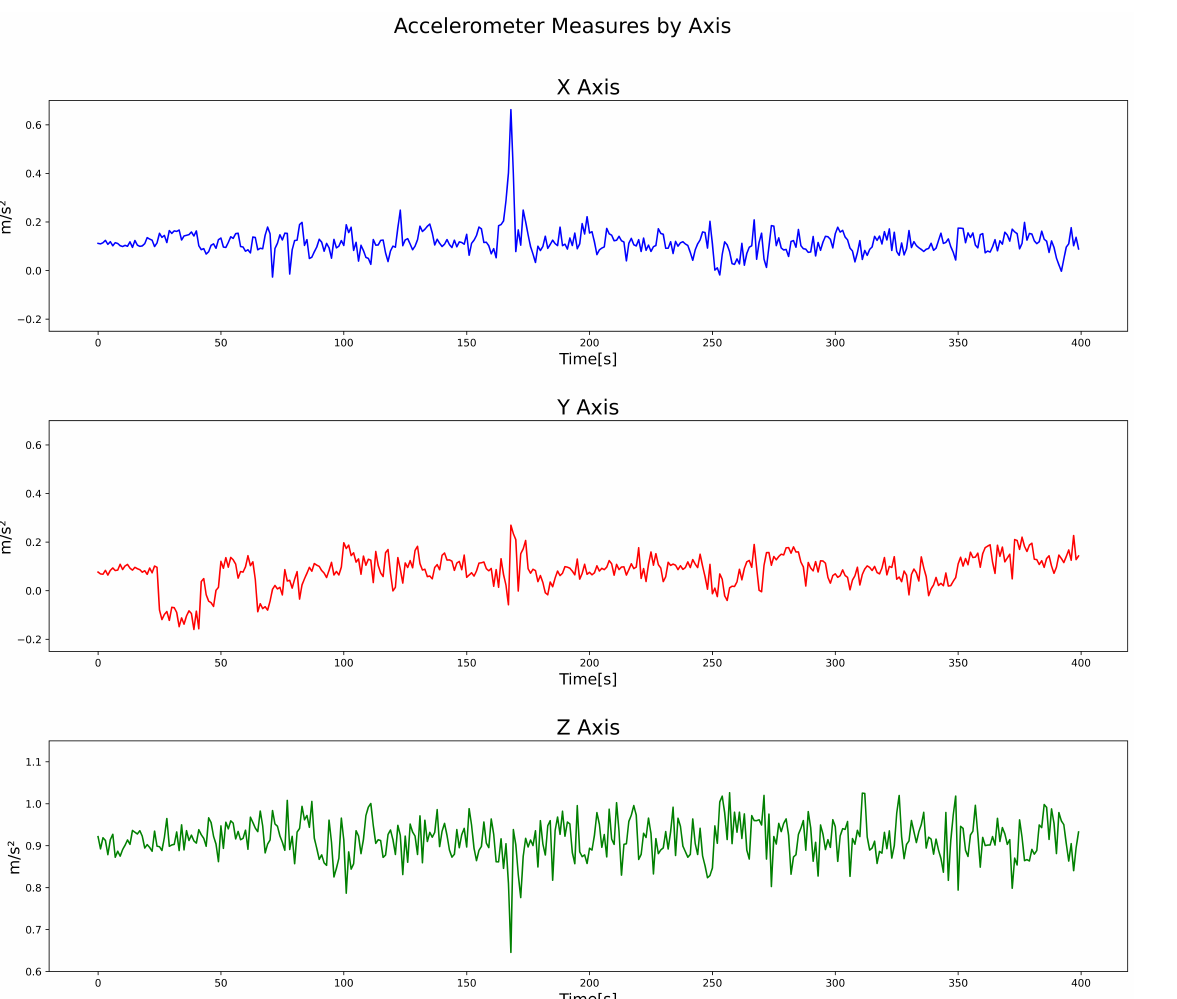
Figure 7. Street with pothole at 20 kmph on